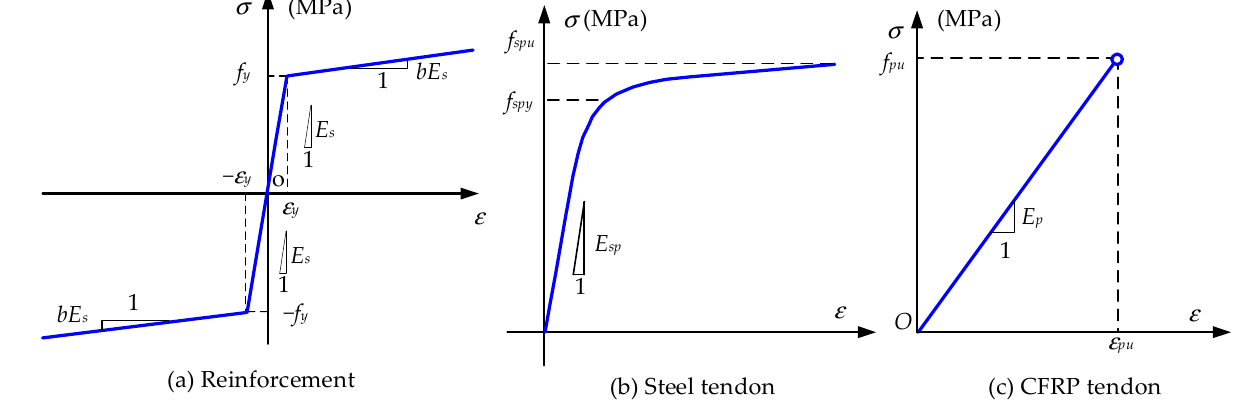
Figure 7. Constitutive model of reinforcement and